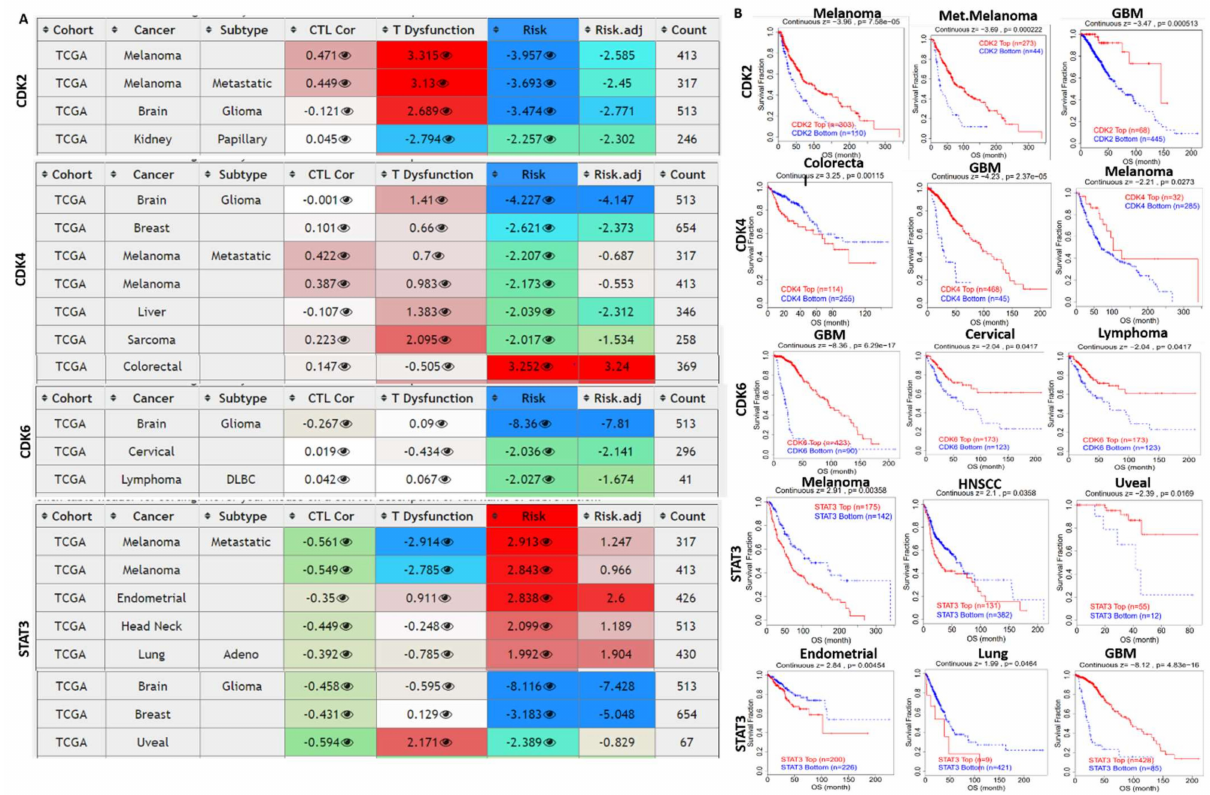
Figure 9. DNA methylation of STAT3/CDK2/4/6 are associated with dysfunctional T-cell phenotypes and are of prog- nostic relevance in multiple cancers. ( A ) Graphical data representation of the effect of STAT3/CDK2/4/6 DNA methy- lation on cytotoxic lymphocyte infiltrations, dysfunctional T-cell phenotypes and risk factor in different TCGA cancer types and subtypes. The deeper the red color and higher positive value indicate poor prognosis with respect to hyper- methylation of STAT3/CDK2/4/6 while the blue to green color indicate poor prognosis with respect to hypo-methylation of STAT3/CDK2/4/6. ( B ) Kaplan Meier curve of the overall survival difference between cancer cohorts with hyper-DNA methylation and hypo-DNA methylation of